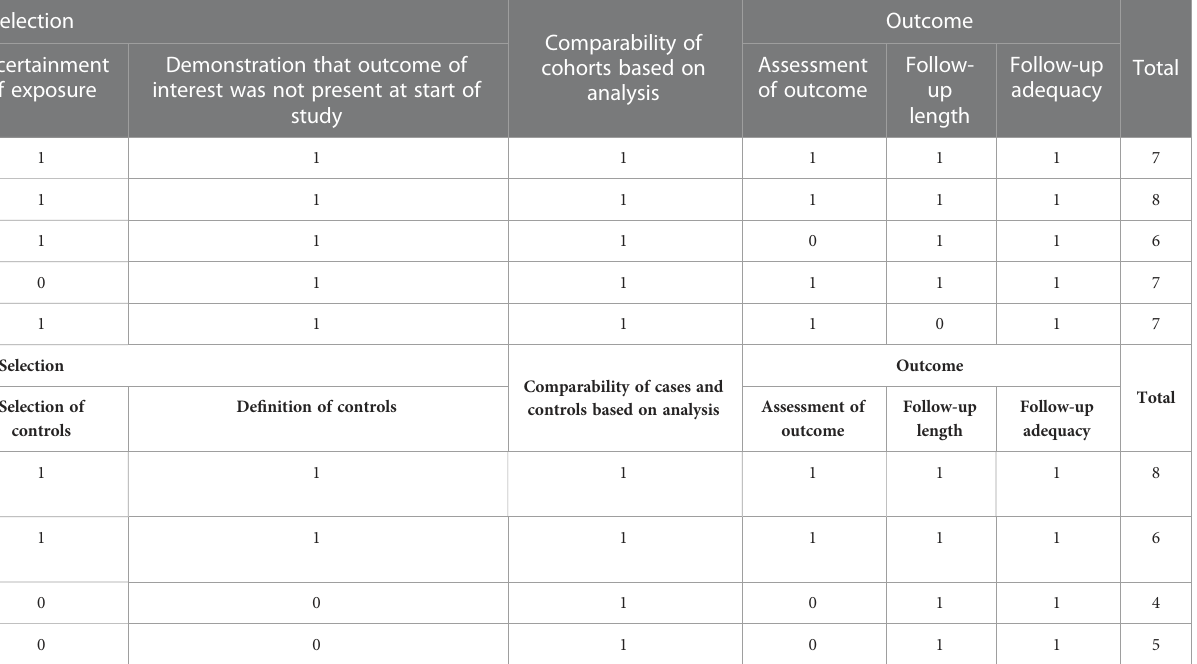
TABLE 2 NOS score of studies included in